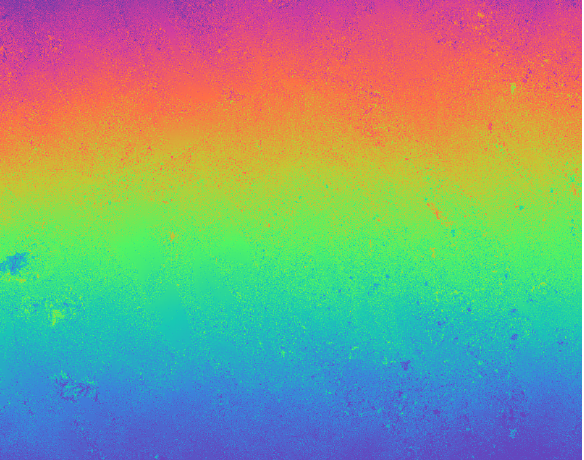
Figure 8. Pair of corregistered images – Master (a) and Slave (b)